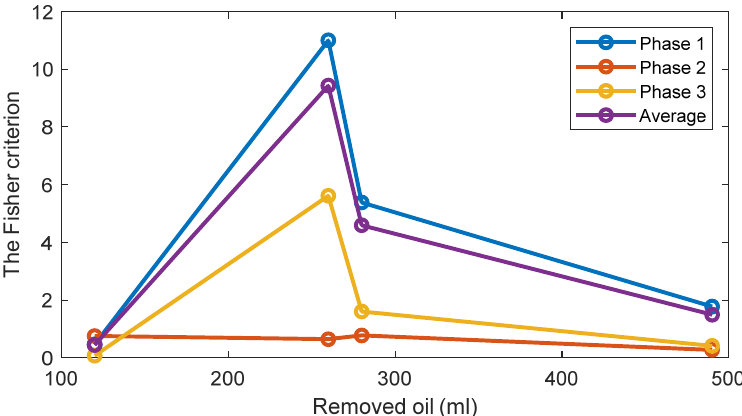
Figure 9. The FC of Feature 1 (the third harmonic of the supply frequency) for three phases and 4 levels of oil removal compared to the standard oil level (Day 2).